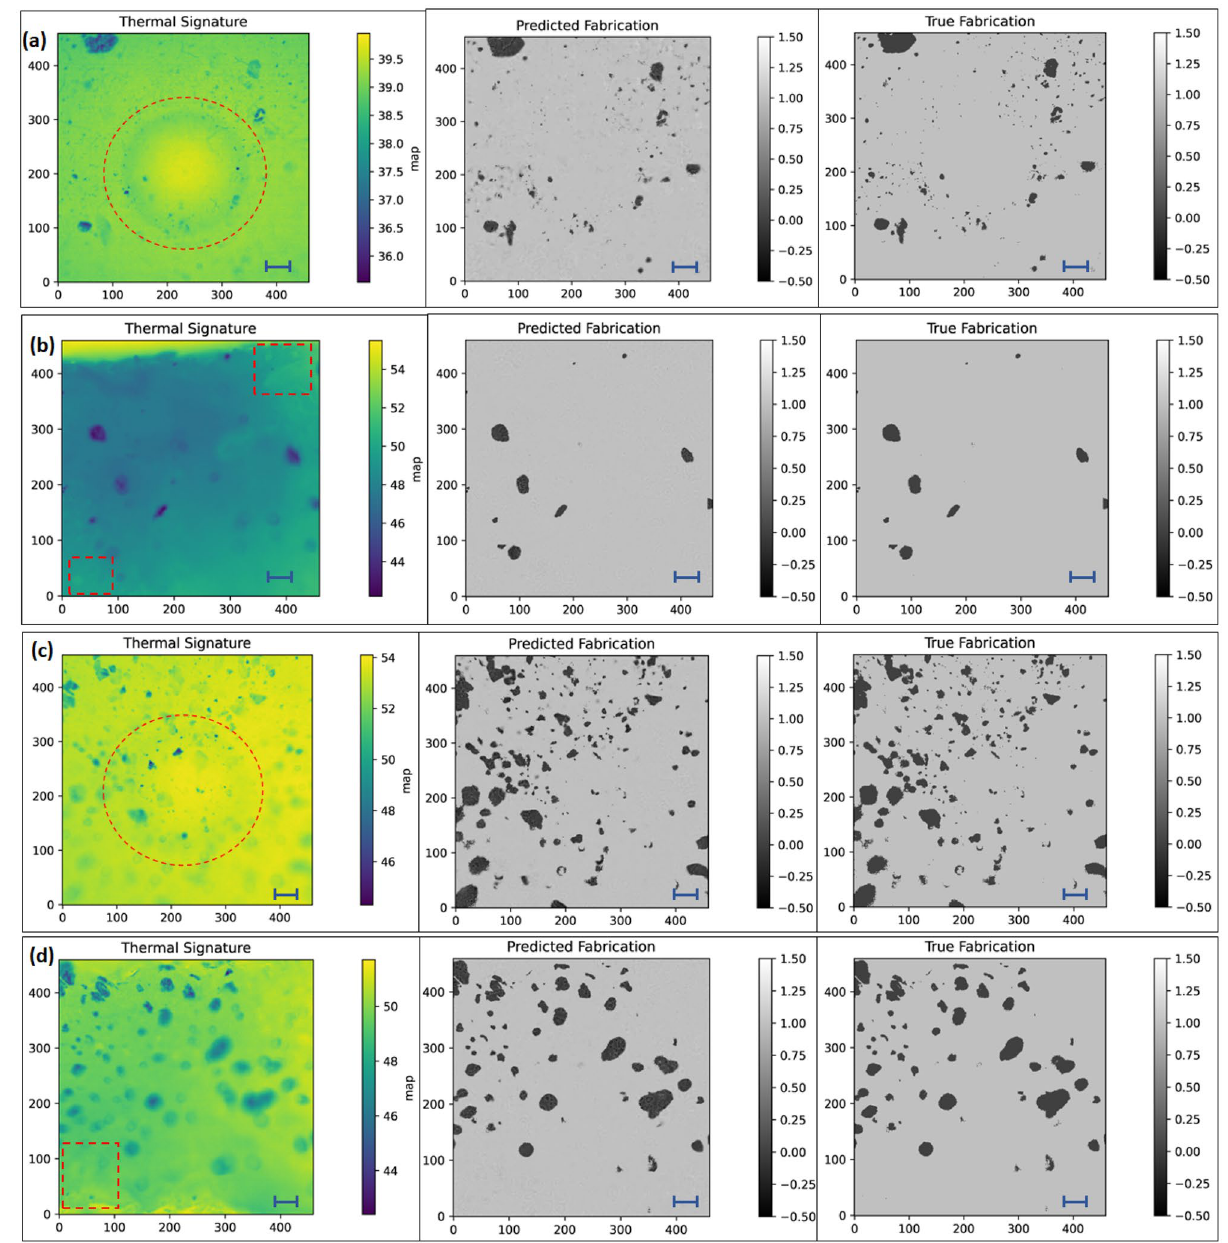
Figure 2. Thermal image, corresponding predicted, and true image for ( a ) 2.5% G Planetary, ( b ) 2.5% G Hand, ( c ) 10% G Planetary, ( d ) 10% G Hand. Thermal image is manually fed in image processing to remove artifacts or voids or blurriness (scale bar = 1000 microns, enclosing red circle area remarks artifact due to container mark, enclosing rectangle area remarks void area). The thermal image is then fed into machine learning model to obtain the true fabrication. By feeding a few thermal signatures, this learning method can show true fabrication in a really quick